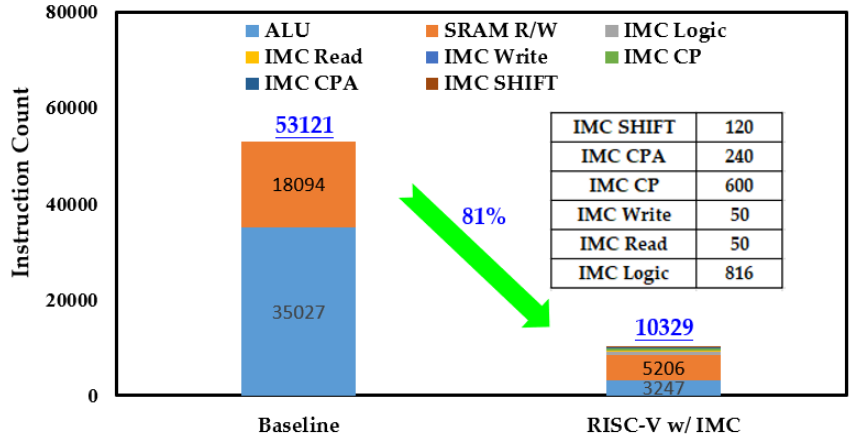
Figure 11. Comparison of instruction count in overall Keccak process.